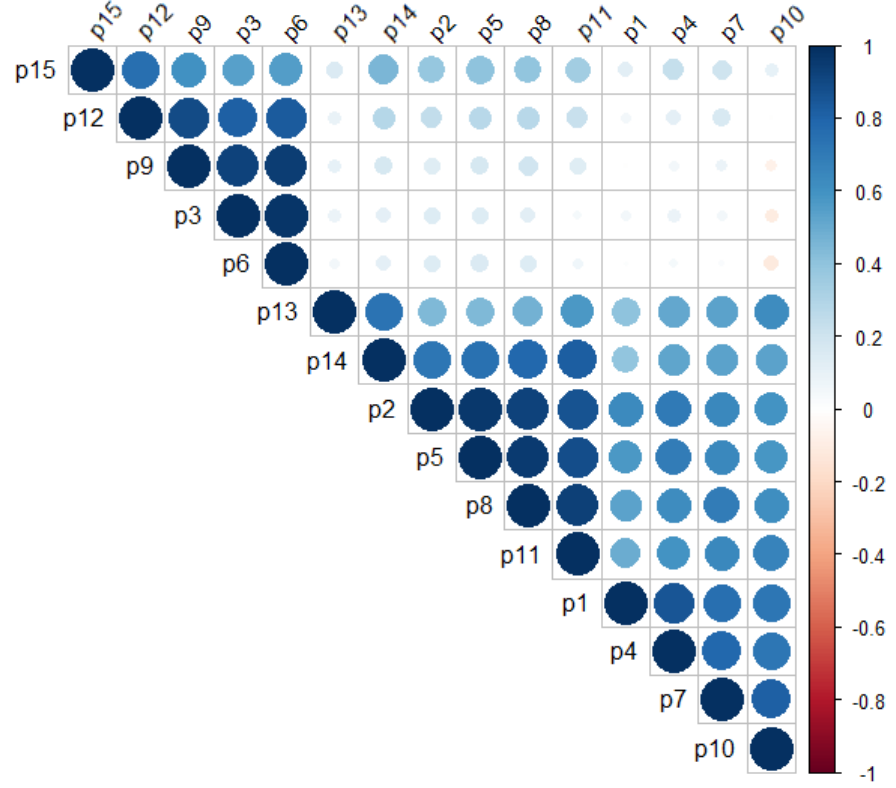
Fig. 2. Correlation diagram plots of all 15 variables (predictors).